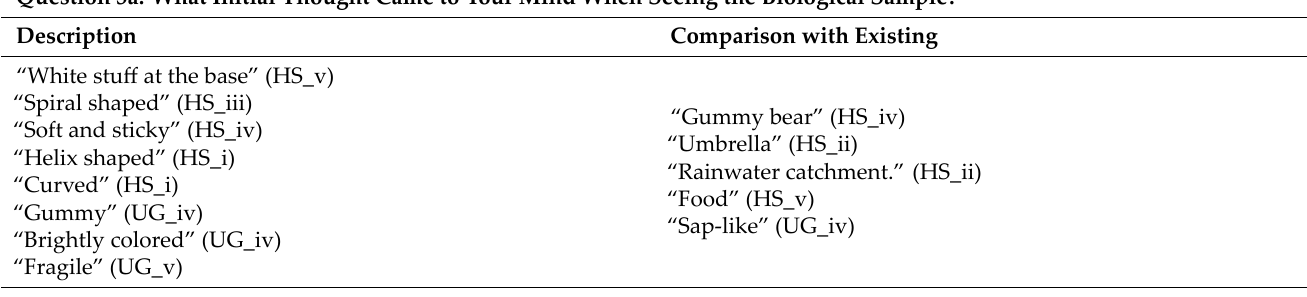
Table 6. Answers to Questions 3a, 3b, and 3c. Examples of answers provided are given, and the students’ group IDs are indicated in